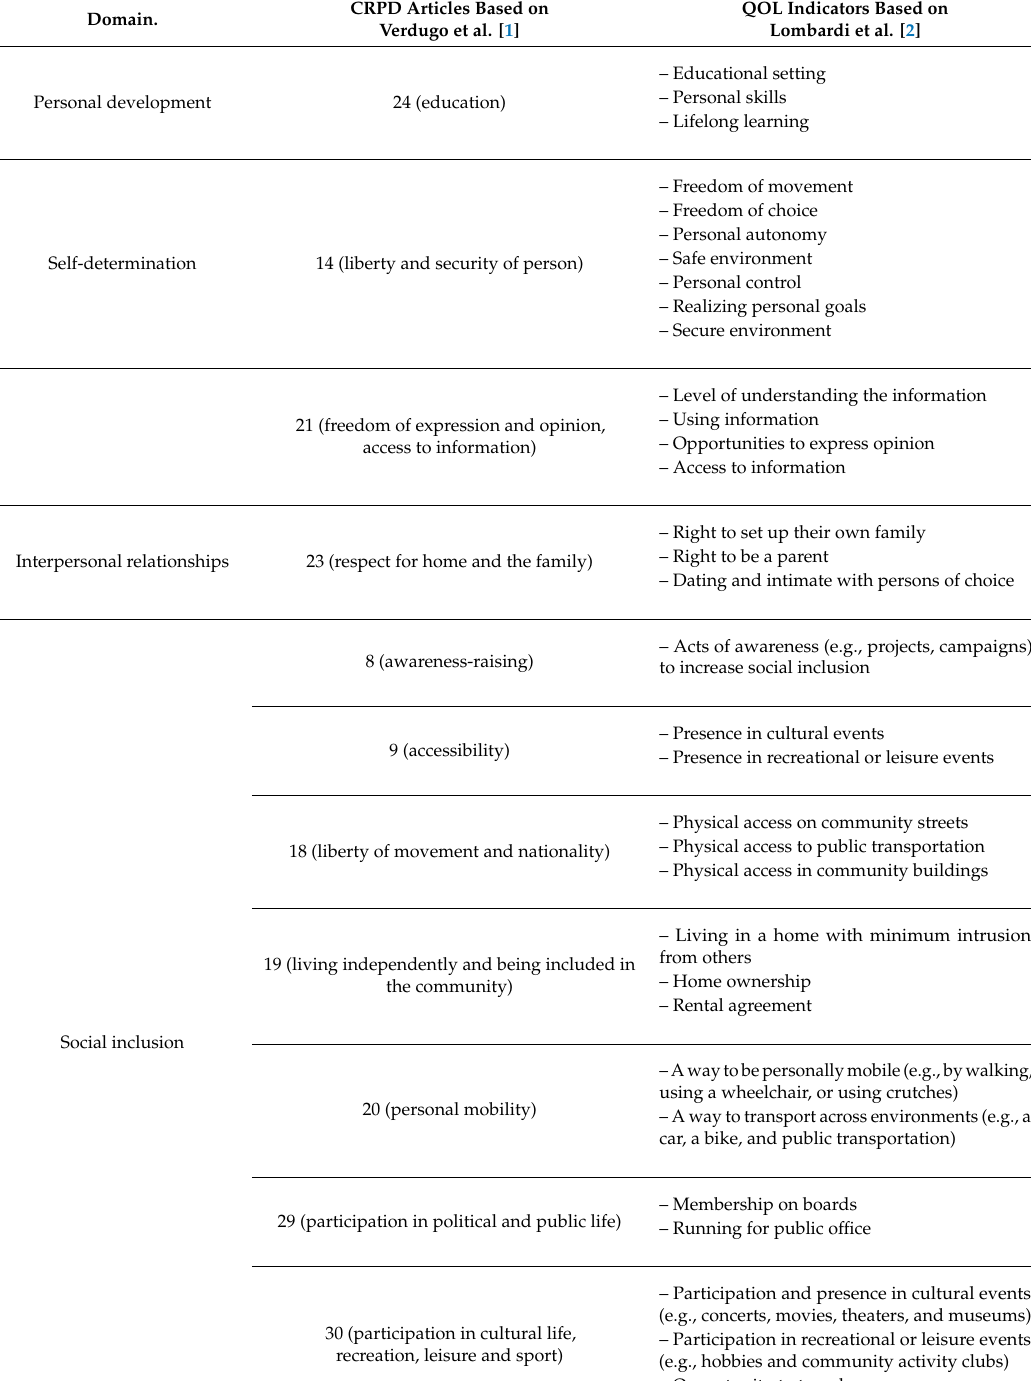
Table 1. Relationship between QOL domains, QOL indicators, and CRPD Articles [adapted from [1,2]].